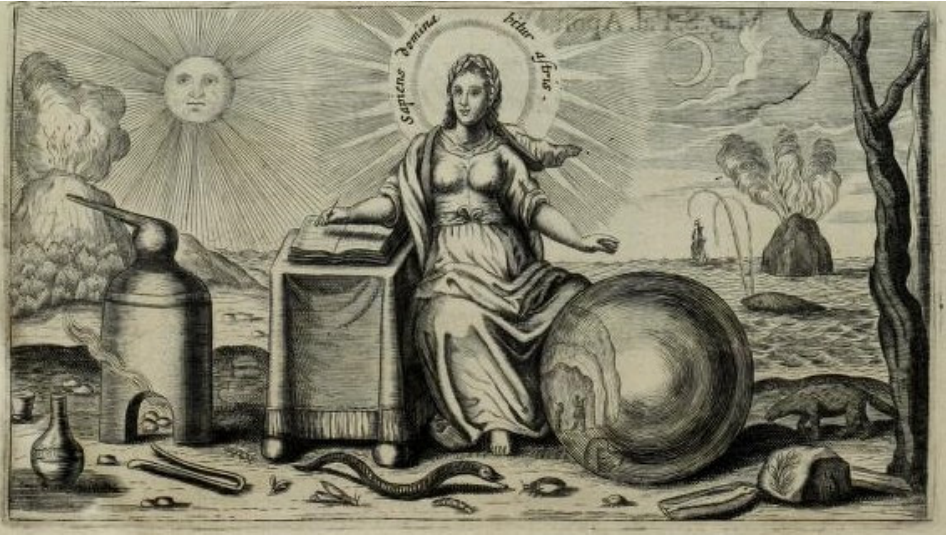
Figure 3. Athanasius Kircher, Mundus Subterraneanus (Amsterdam: Joannem Janssonium and Elizeum Weyerstraten, 1665), close-up of the bottom center section of the frontispiece. Public Domain.